Question: Does the figure show an increasing or a decreasing trend?
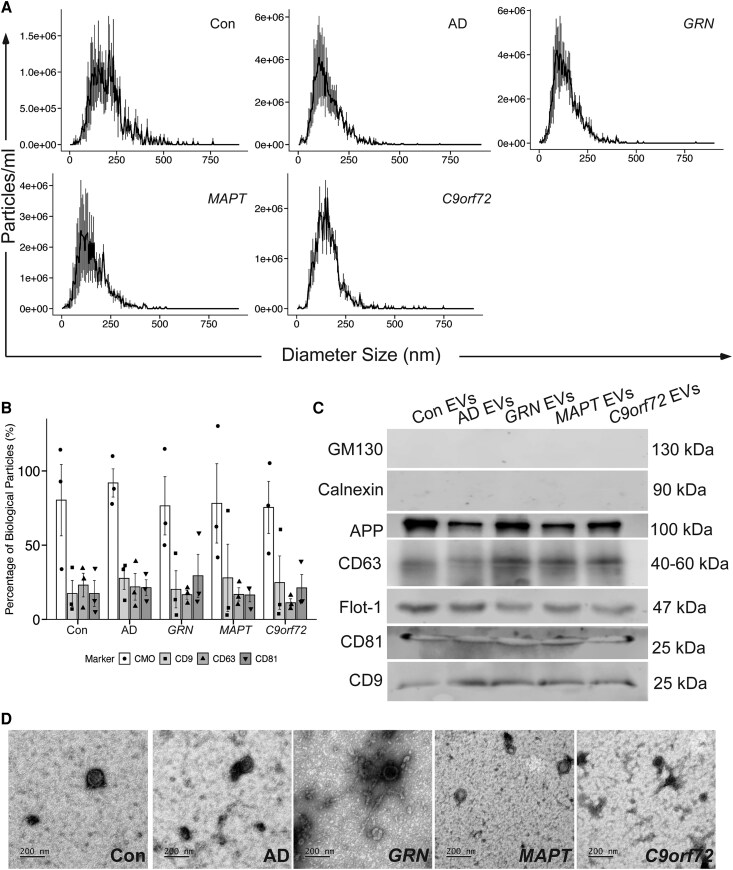
Answer: decreasing